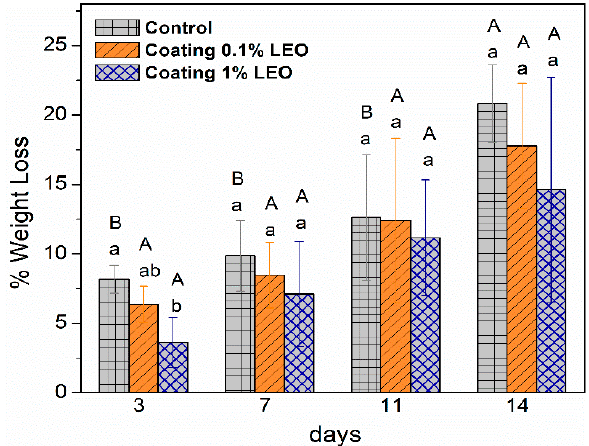
Figure 3. Weight loss percentage of coated and uncoated (control) fresh-cut apples with different treatment during storage at 4 °C. Means with the same letters (lowercase: amongst different treatments for the same time; uppercase: for the same treatment during different storage times) are not significantly different according to Tukey’s test ( p > 0.05). Vertical bars indicate standard deviation.